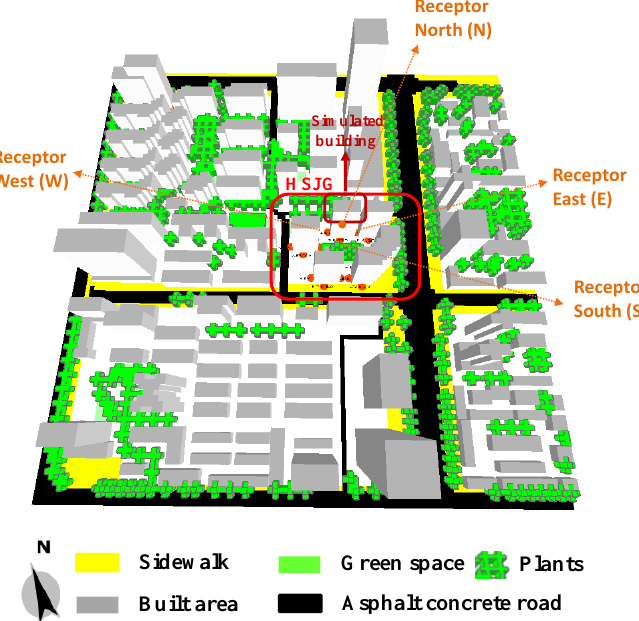
Figure 5. The 3D model of the simulated area and four receptors in ENVI-met.